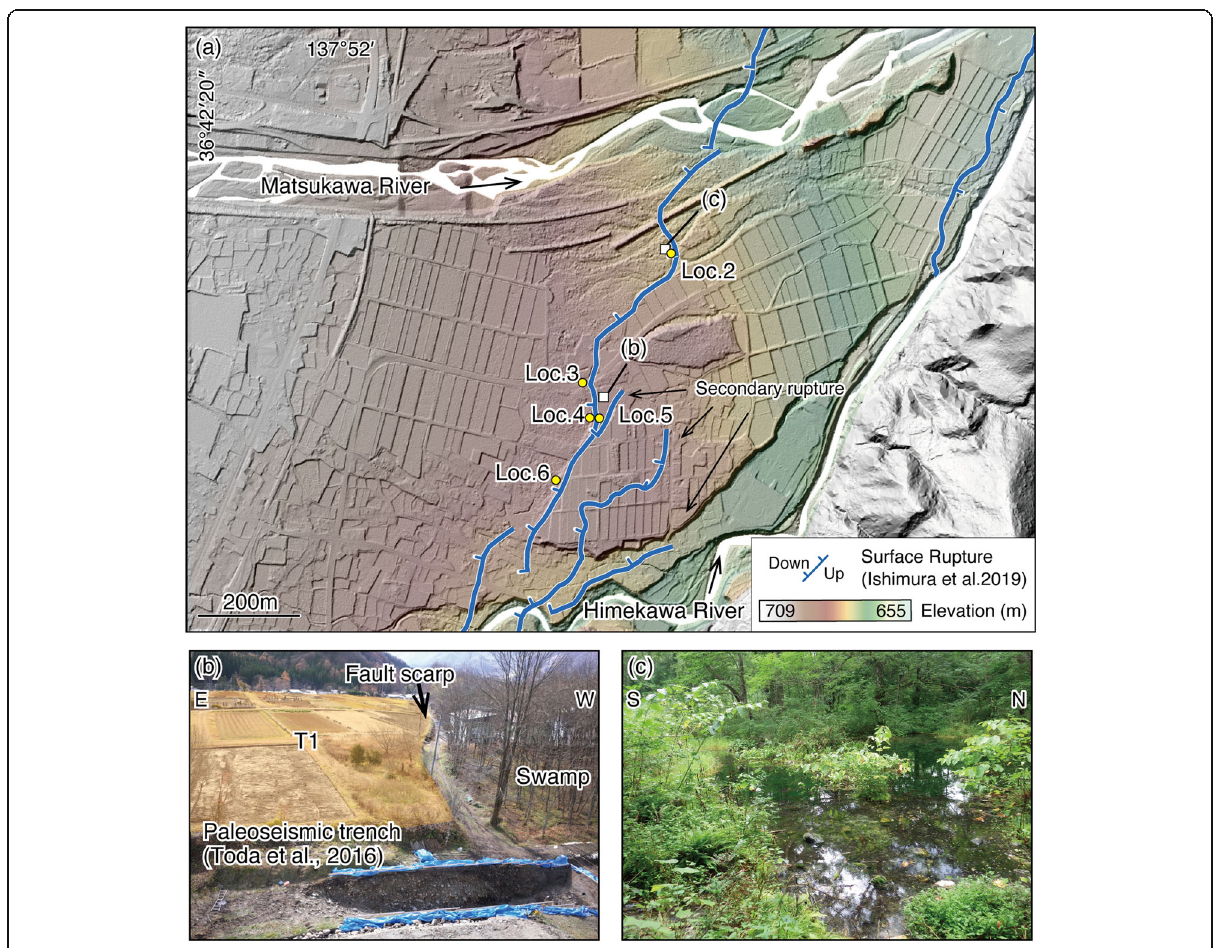
Fig. 3 Topography around Oide in the northern section of the 2014 rupture zone. a Color-coded altitudes and 14 C sampling sites. The black arrows in rivers indicate flow direction. b Fault scarp running between an uplifted terrace and swamp on the footwall side. c A shallow pond developed on the footwall. Radiocarbon samples were taken from this pond to estimate the age of T5 (Fig. 8). The locations of b and c are shown in